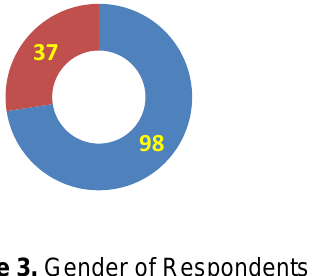
Figure 3. Gender of Respondents